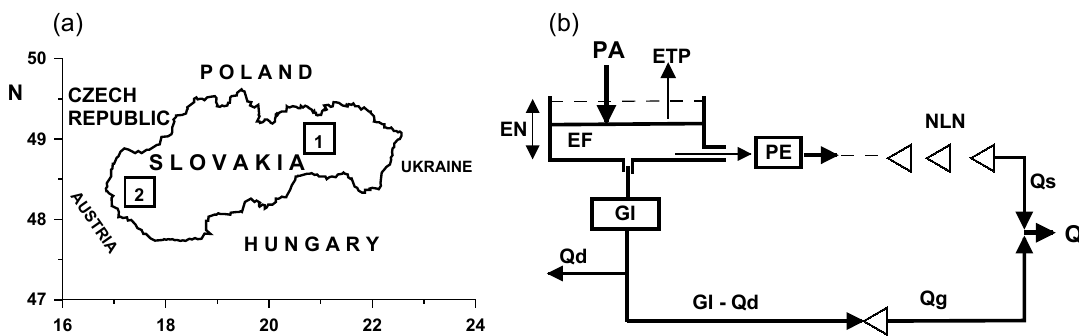
Fig. 1 (a) Location of the catchments. (b) Schematic of the NLC model